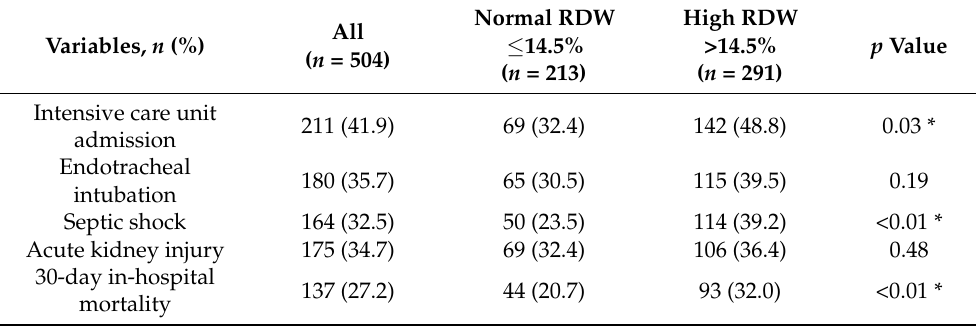
Table 2. Outcome analysis of patients with sepsis based on their initial red cell distribution width ( n = 504).